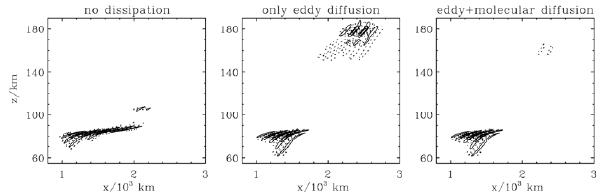
Fig. 7. Normalized horizontal perturbation velocity at 12h for three different conditions. The minimum values and intervals of the con- Figure 7. Normalized horizontal perturbation velocity at 12 hr for three different conditions. The 718 tours are, respectively, 0.1 and 0.2. The maximum absolute values are, respectively, 8.27, 1.52, and 1.52ms − 1 for the three minimum values and intervals of the contours are, respectively, 0.1 and 0.2. The maximum absolute 719 values are, respectively, 8.27, 1.52, and 1.52 m s –1 for the three conditions. 720